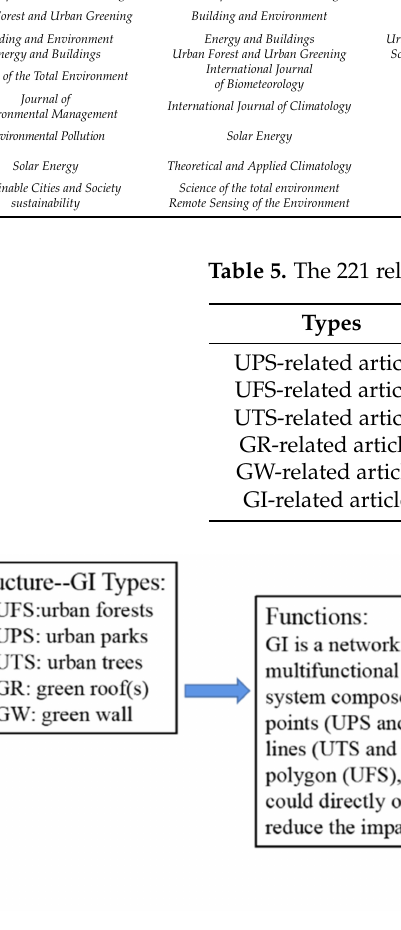
Figure 8. Conceptual framework describing GI analysis used in this